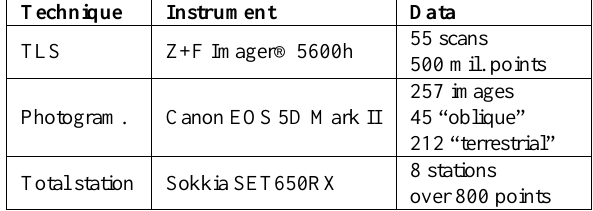
Table 2 Terrestrial surveying of the archaeological area of S. Omobono – Insula Volusiana.